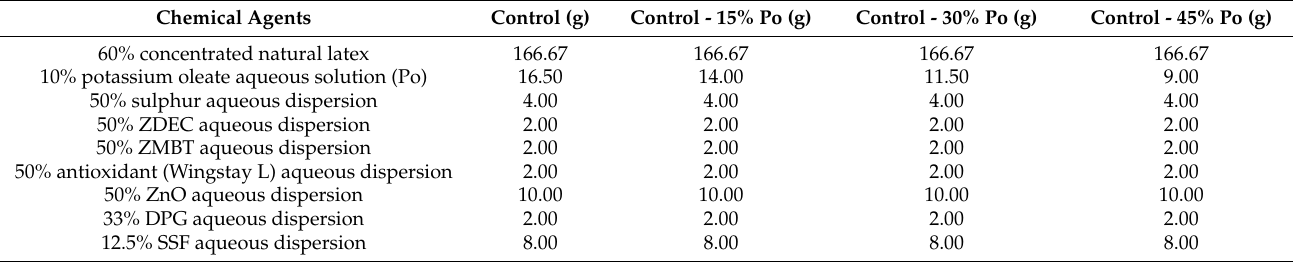
Table 1. Formulas of rubber foams at various chemical blowing agents: control sample, control sample with decreasing Po at 15% (control - 15% Po), control sample with decreasing Po at 30% (control - 30% Po), and control sample with decreasing Po at 45% (control - 45%